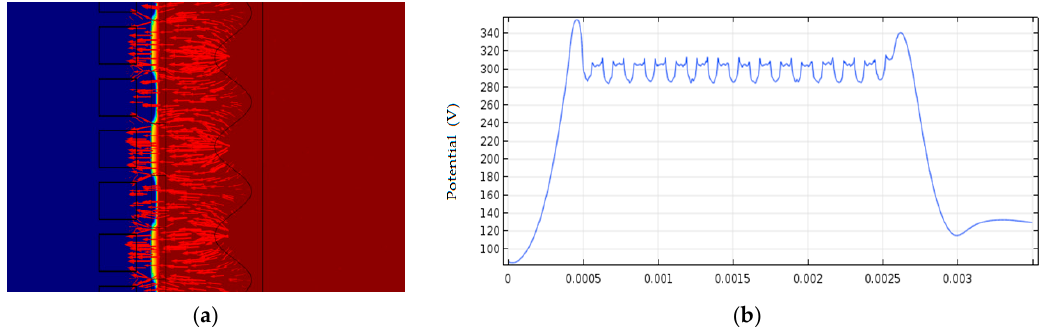
Figure 7. Simulation results. ( a ) electric field simulation; ( b ) the electric field strength.